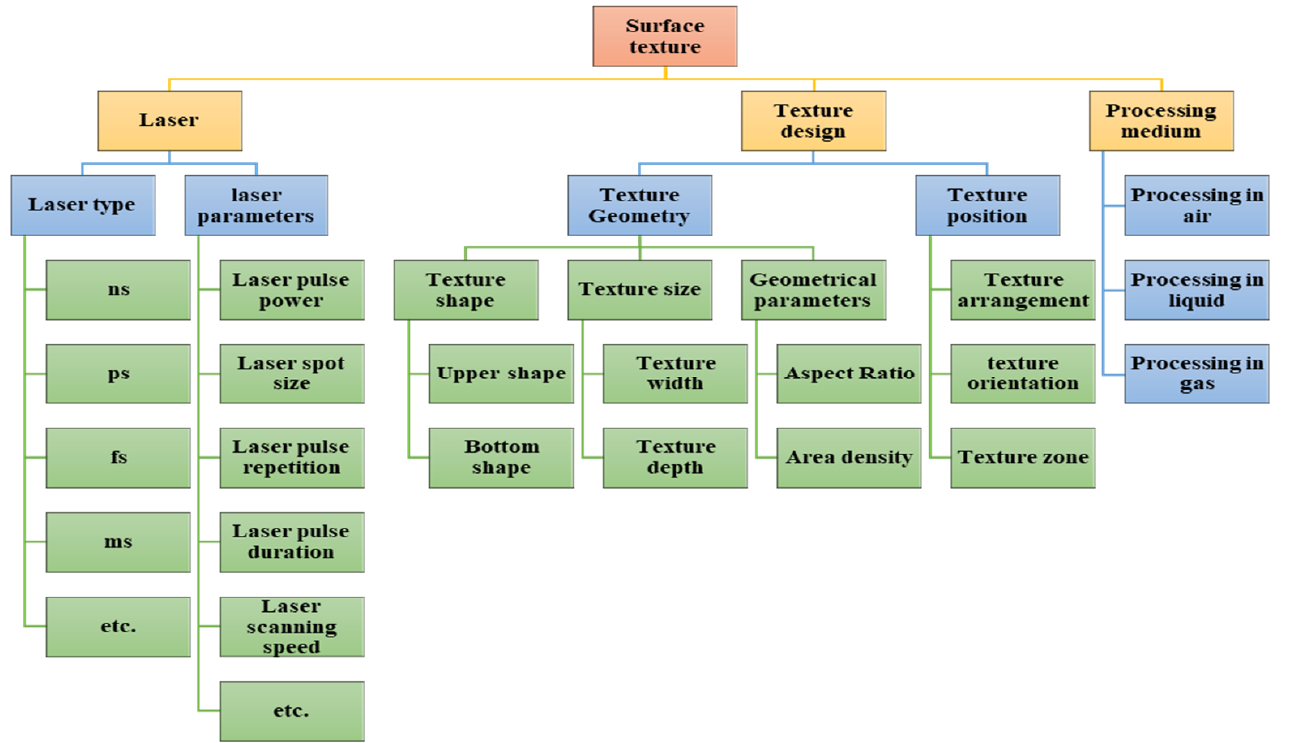
Figure 1. Laser surface texture technology features.